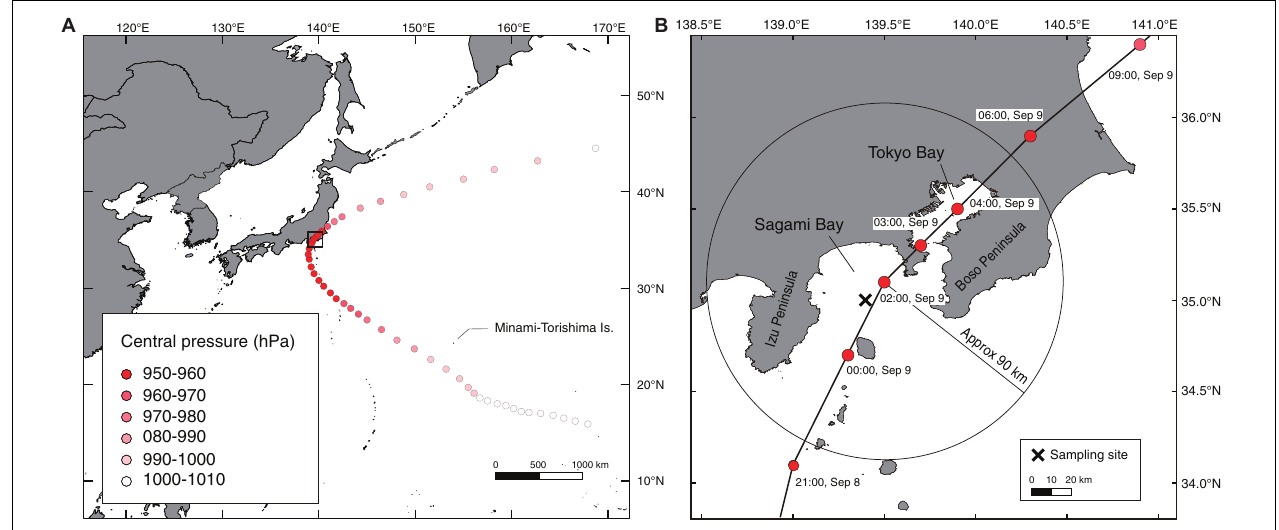
FIGURE 1 | Track of typhoon Faxai off (A) the east coast of Japan and (B) over Sagami Bay. The colors of circles on (A,B) donate the central pressure (hPa) of Faxai . Large circle on (B) represents the area of the storm with the wind speed of > 25 m/s (02:00 September 9th). Cross on (B) donates sampling site.